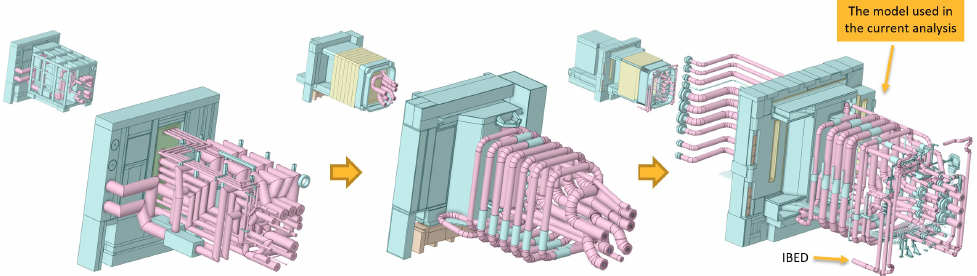
Figure 1. PF and BP Evolution through 2018 [2] ( Left ), 2019 [3] ( Middle ), and 2021 ( Right